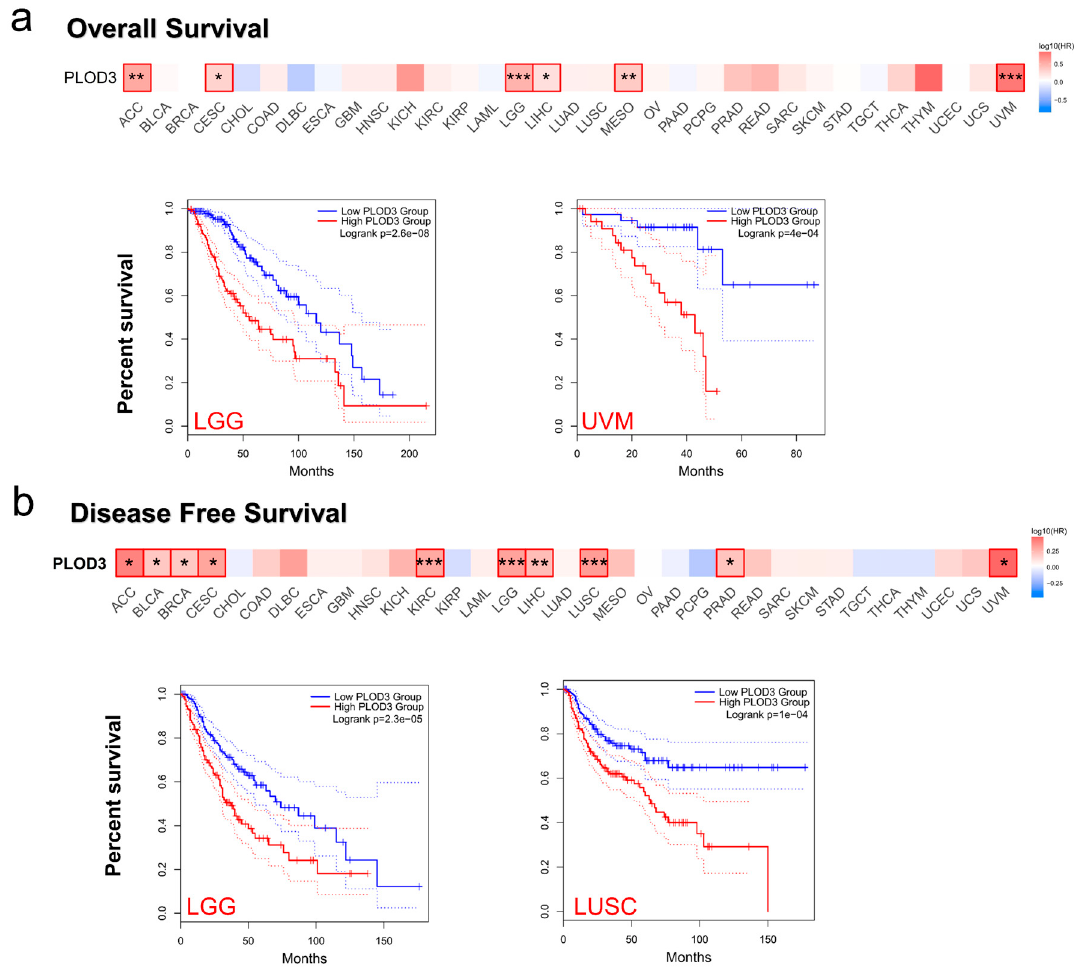
Figure 5. Relation between PLOD3 expression and survival prognosis of different cancers in TCGA. GEPIA2 tool was used to obtain the OS ( a ) and DFS ( b ) analyses of different tumors in TCGA. The survival maps and Kaplan–Meier curves are shown. Dotted lines: 95% confidence interval. * p < 0.05, ** p < 0.01, *** p < 0.001.